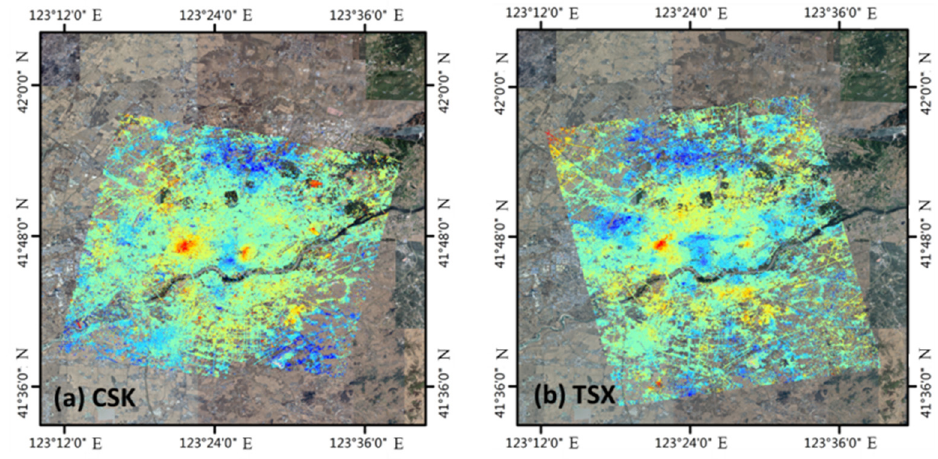
Figure 12. Mean ground velocity maps over Shenyang: ( a ) CSK data and ( b ) TerraSAR-X (TSX)